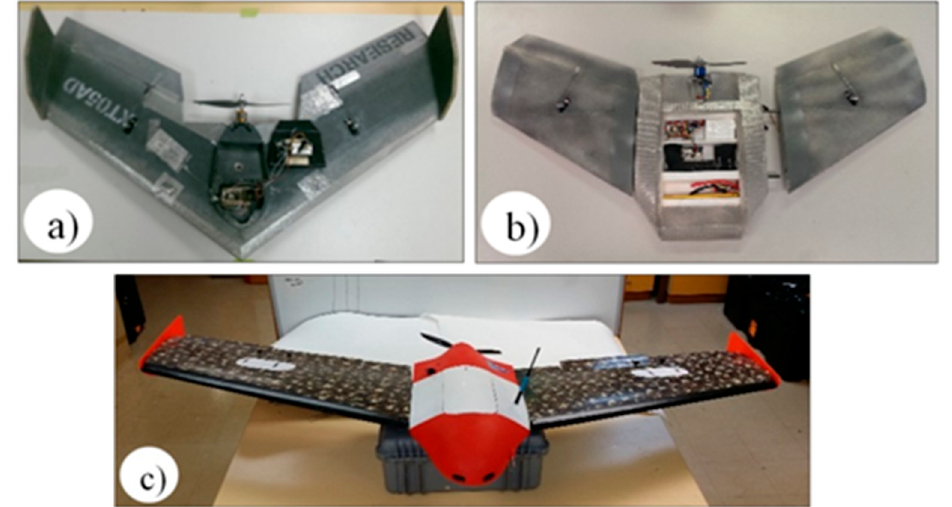
Figure 4. Fixed-wing UAV platforms, ( a ) Teklite; ( b ) GoSurv; and ( c ) Swamp